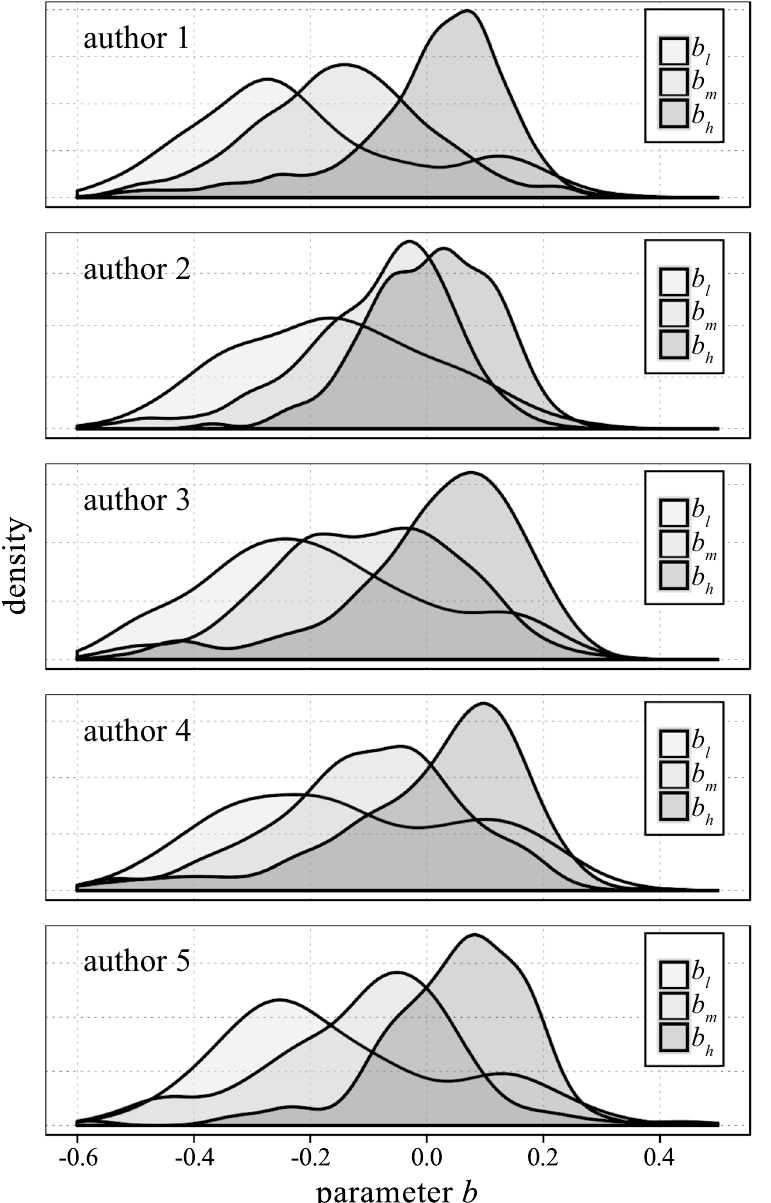
Figure11. Variation of the distributions of b l , b m and b h